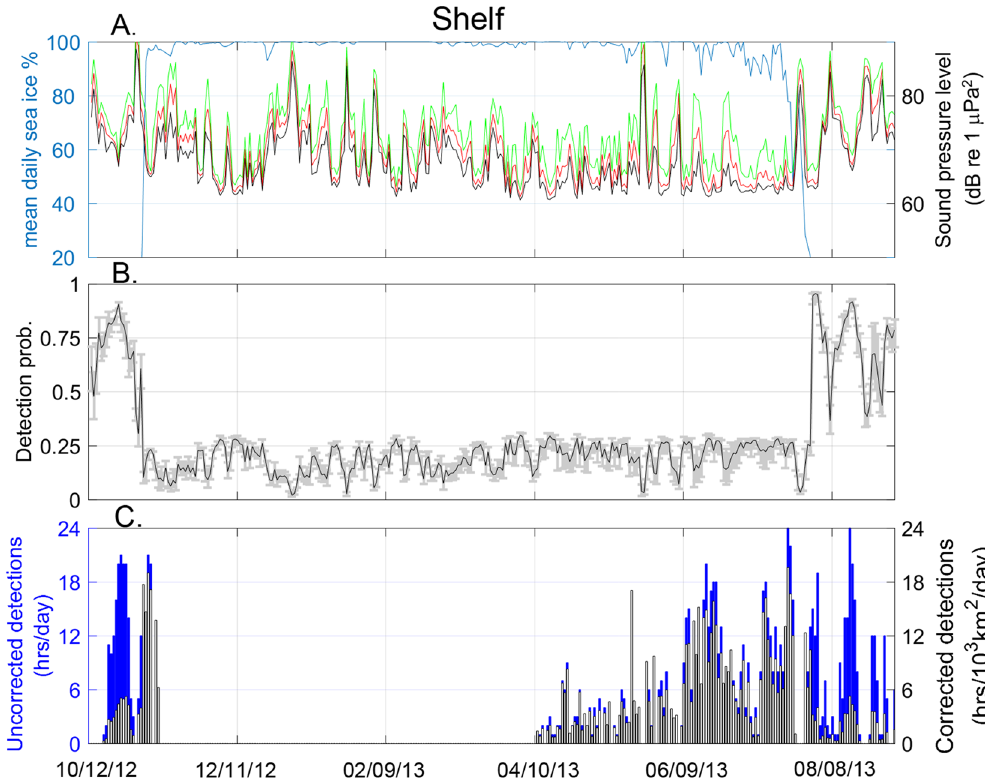
Figure 9. Shelf site ( A ) Average daily ambient noise levels in daily 10th 50th, and 90th percentiles (black, red, and green lines, respectively) for 80–180 Hz frequency band and mean daily sea ice concentration (blue line from October 2012 to October 2013. ( B ) Daily detection probability within a 40 km radius, gray bars show range for the 90th and 10th percentile noise level. ( C ) Bowhead whale call detections as uncompensated daily detection hours (blue bars) and compensated detection density (black and white